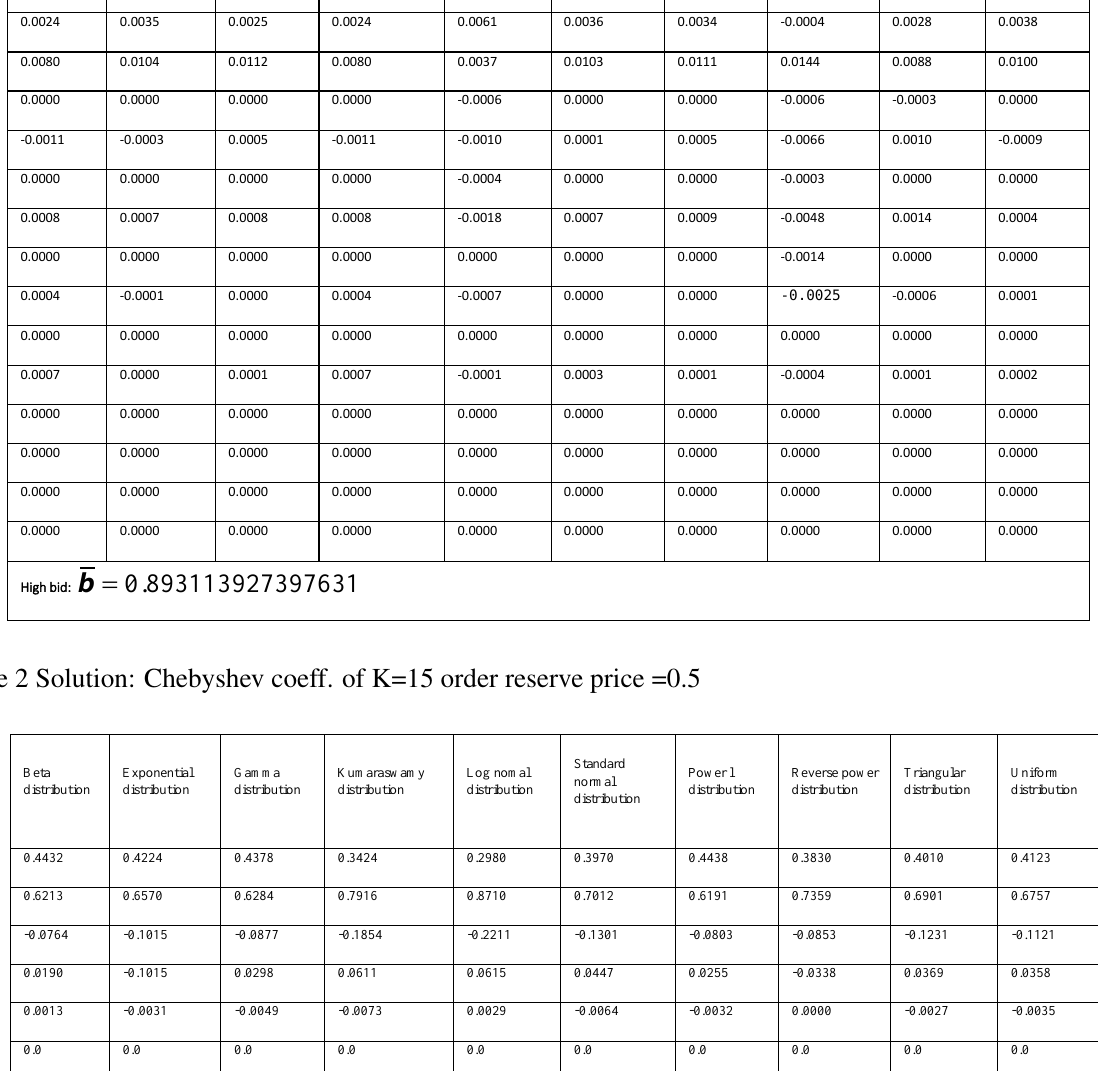
Beta distribution